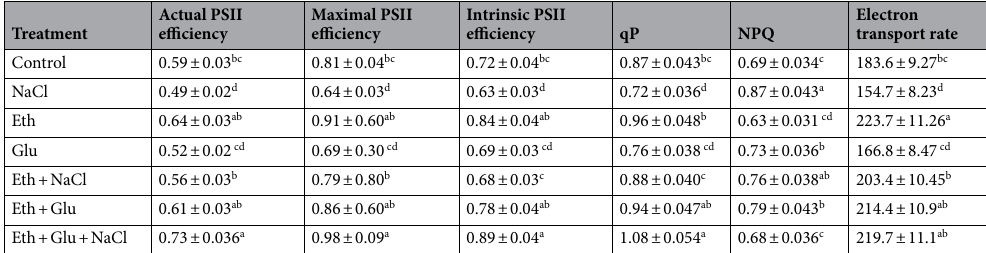
Table 2. Actual PSII efficiency, maximal PSII efficiency, intrinsic PSII efficiency, photochemical quenching (qP), non-photochemical quenching (NPQ) and electron transport rate of wheat ( Triticum aestivum L.) cultivar WH 711 treated with 200 µL L −1 ethephon (Eth) and / or 6% glucose (Glu) in presence or absence of 100 mM NaCl at 30 d after sowing. Data are presented as treatment mean ± SE (n = 4). Data followed by same letter are not significantly different by LSD test at p <